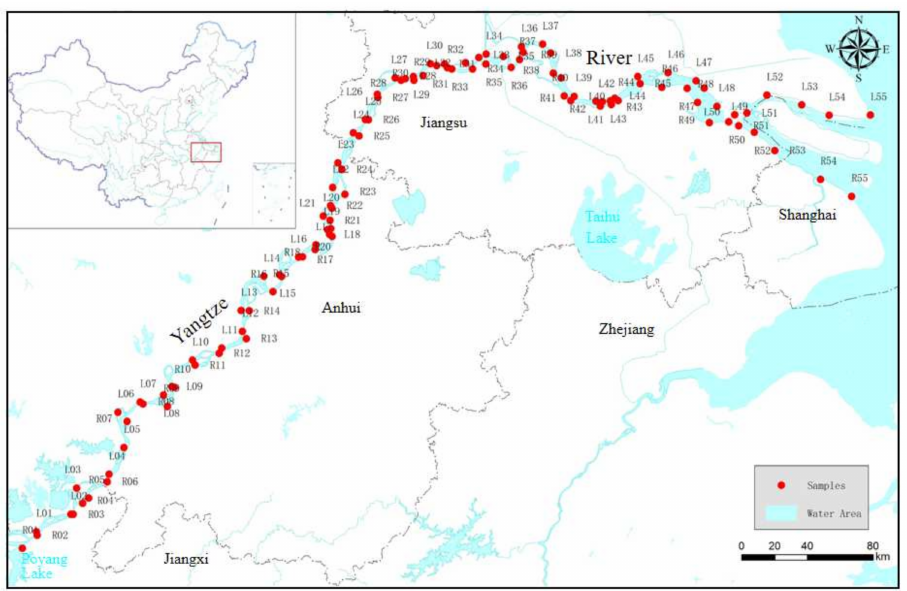
Figure 1. Location of studied area and distribution of sampling